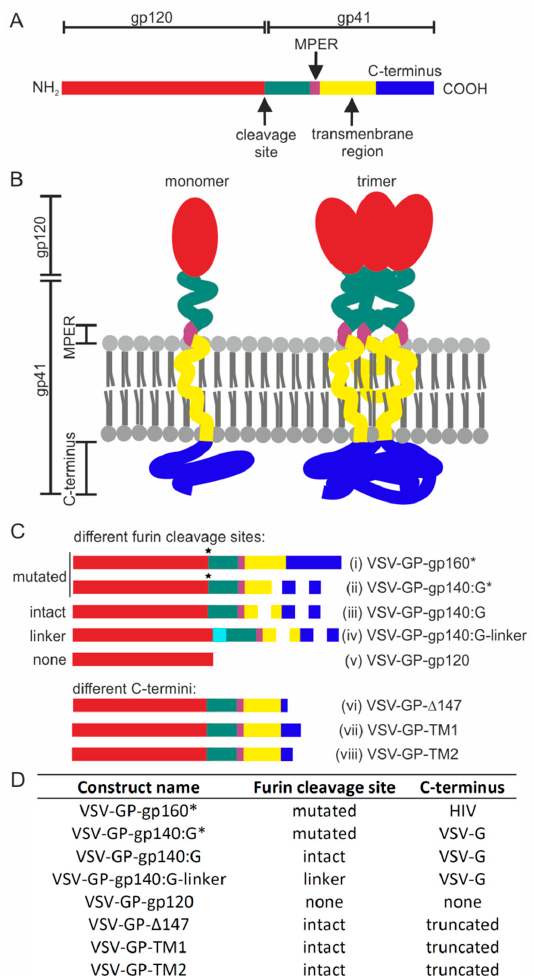
Figure 1. Schematic overview of human immunodeficiency virus (HIV) Env variants. The linear structure of HIV gp160 ( A ) and the three-dimensional structure of the monomers and trimers on the surface of infected cells or viral particles ( B ) are shown. ( C ) Schematic overview of HIV Env variants that were cloned into position 5 of VSV-GP vectors. Color coding: gp120 (red), extracellular part of gp41 (green), MPER (membrane-proximal external region; purple), transmembrane domain (TM; solid line for HIV-TM or dotted line for vesicular stomatitis virus glycoprotein (VSV-G)-TM, yellow) and C-terminus (solid line for HIV C-terminus or dotted line for VSV-G C-terminus, dark blue). Constructs contained either a functional furin cleavage site, a mutated furin cleavage site (indicated by an asterisk) or a flexible linker replacing the furin cleavage site (light blue). (i) gp160* = full-length HIV Env with a mutated furin cleavage site, (ii) gp140:G* = gp140 fused to the transmembrane domain and cytoplasmic tail of VSV-G with a mutated furin cleavage site, (iii) gp140:G = gp140 fused to the transmembrane domain and cytoplasmic tail of VSV-G with an intact furin cleavage site, (iv) gp140:G-linker = gp140 fused to the transmembrane domain and cytoplasmic tail of VSV-G with a flexible linker replacing the furin cleavage site, (v) gp120, (vi) ∆ 147 = truncated HIV Env with only 3 intracellular amino acids at the C-terminus, and an intact furin cleavage site, (vii) TM1 = HIV Env with an SIV segment insertion at the C-terminus, a Y712I mutation, a STOP codon after F717, and a native furin cleavage site, and (viii) TM2 = HIV Env with the SIV segment insertion, a deletion of GY711-712, R722G and S727P mutations (SIV mac239 numbering), a STOP codon after F717, and an intact furin cleavage site. ( D ) Furin cleavage site configuration and C-terminus for all constructs are